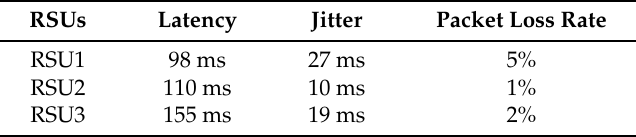
Table 2. Performance parameter values of RSUs.